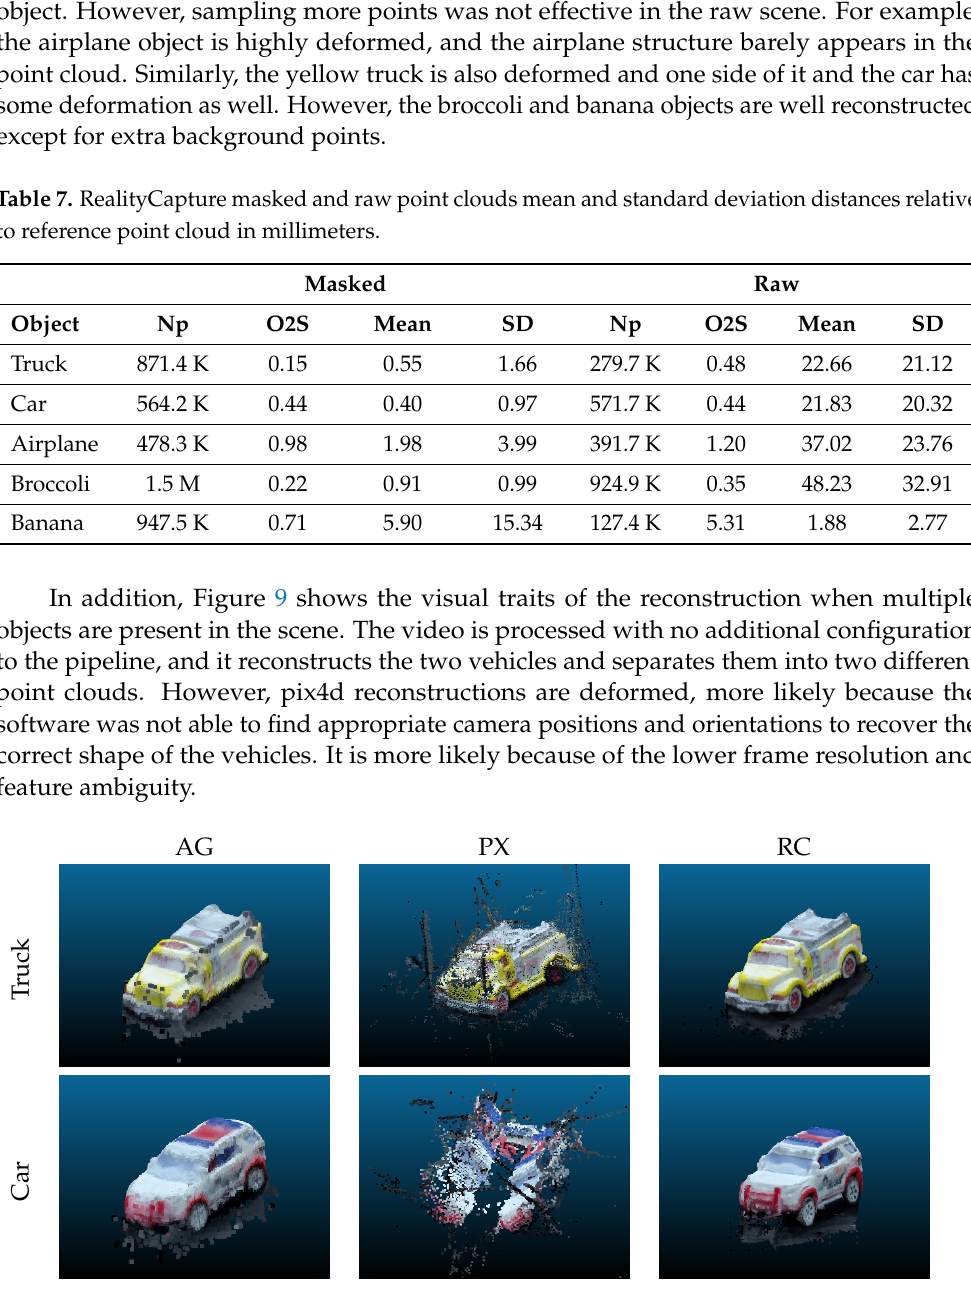
Figure 9. Agisoft (AG), Pix4d (PX), and RealityCaptures (RC) visuals for the different point